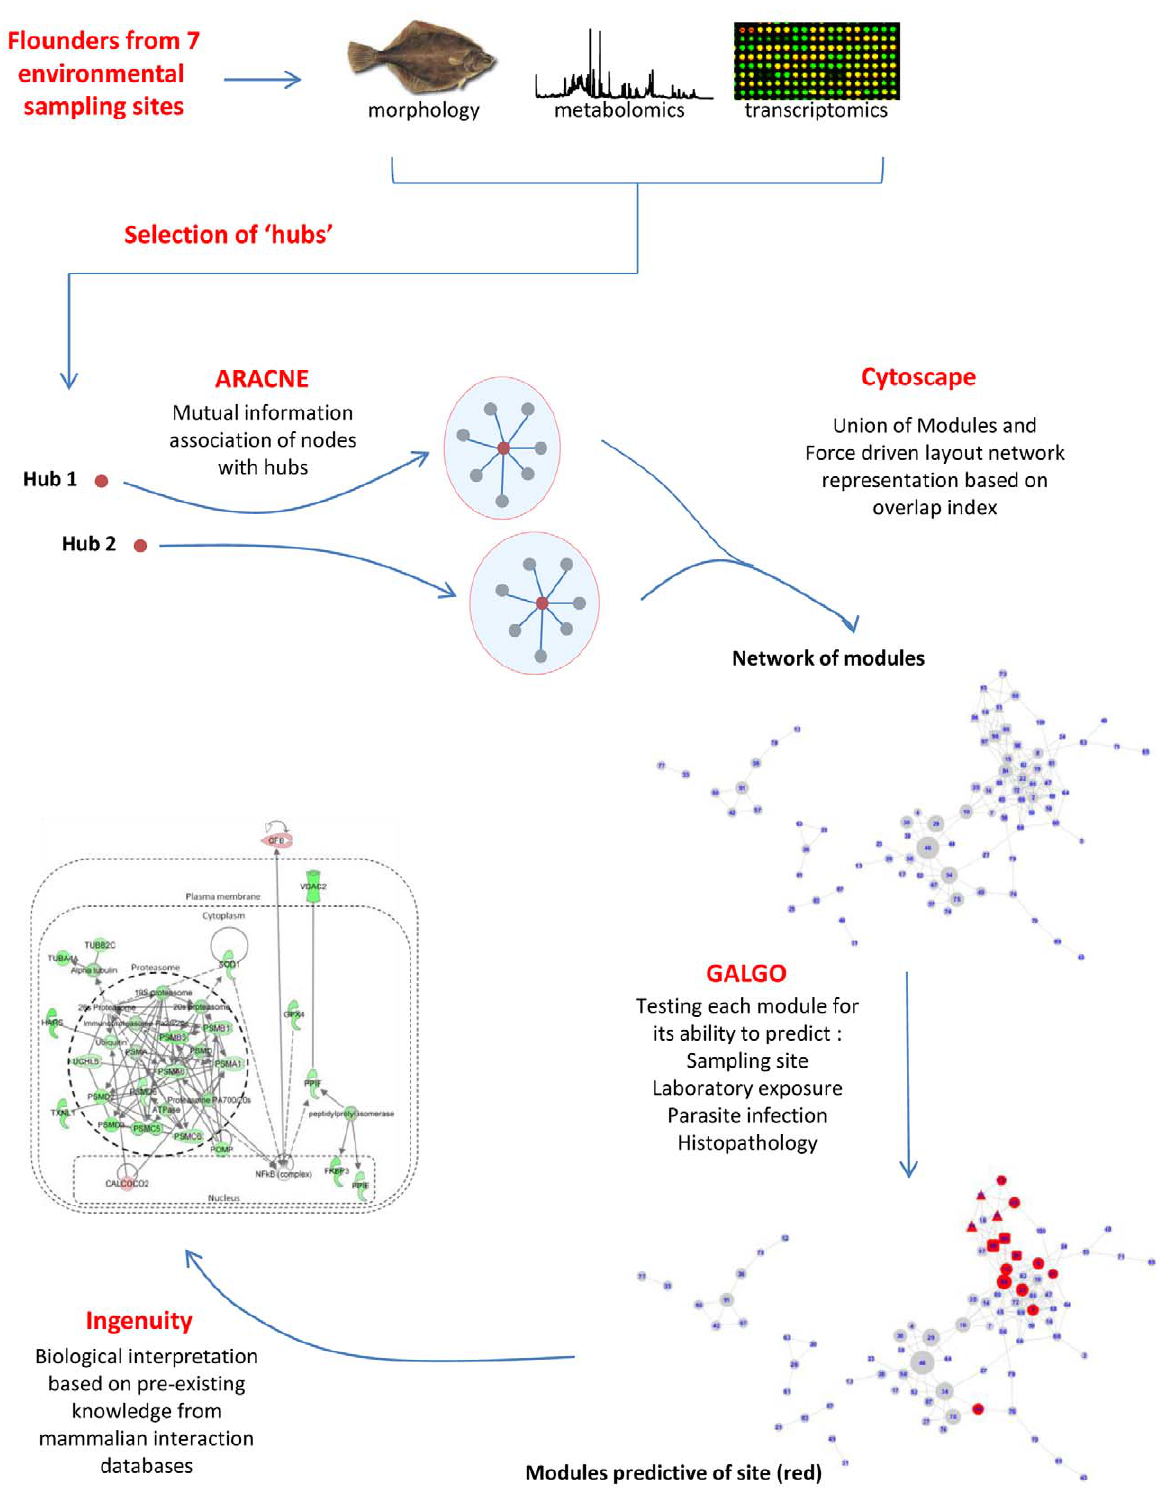
Figure 1. Experimental scheme. A schematic representation of the analysis workflow and the network inference methodology.